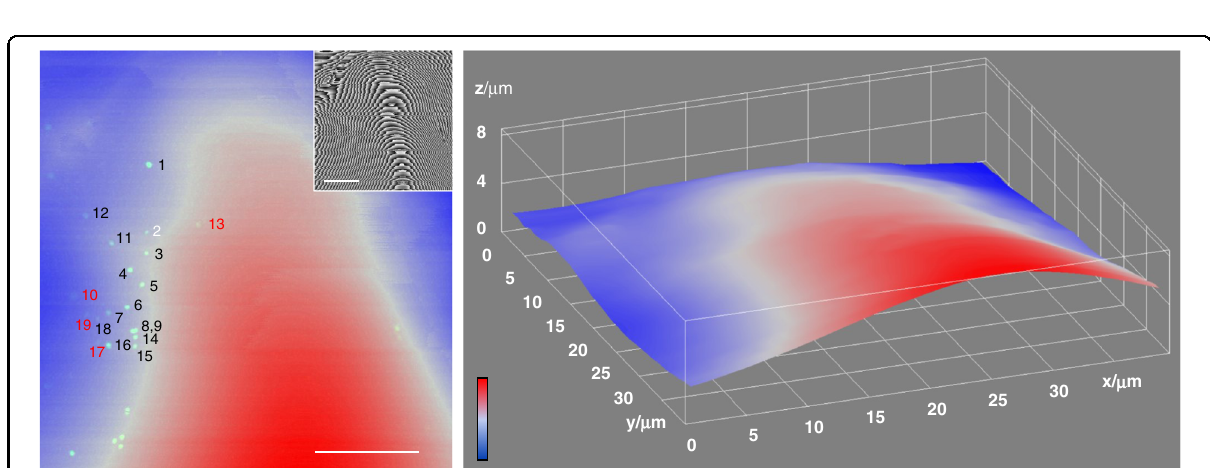
Fig. 4 Surface height pro fi le of resin section in FWM imaging. Colour-coded height pro fi le (blue: 0, red: 8.51 µm) obtained from the phase of the re fl ected probe fi eld, shown in the inset on a grey scale from − π (black) to π (white), for the region in Fig. 1c and Fig. S7. The FWM fi eld amplitude of AuNPs is overlaid on the left panel and AuNPs are labelled. The surface pro fi le shows height differences of several microns, indicating a ripple in the pioloform layer and the supported 300 nm thin resin section. AuNPs labelled in red are those excluded from the CLEM correlation analysis as they are too out of focus (AuNP 10 is 1.9 µm below and AuNP 13 is 0.8 µm above AuNP 5). Scale bar: 10